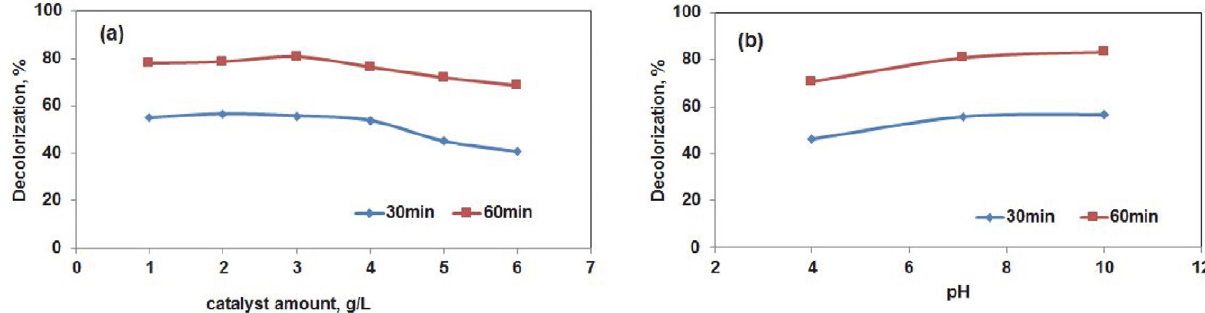
Fig. 5. Effect of (a) m-ZZF amount (initial dye concentration: 0.04 g/L, initial temperature: 25 °C, original pH, H 2 O 2 amount 2.78 g/L, UV light) (b) pH (initial dye concentration: 0.04 g/L, initial temperature: 25 °C, H 2 O 2 amount 2.78 g/L, m-ZZF amount: 3 g/L, UV light) on the decolorization of